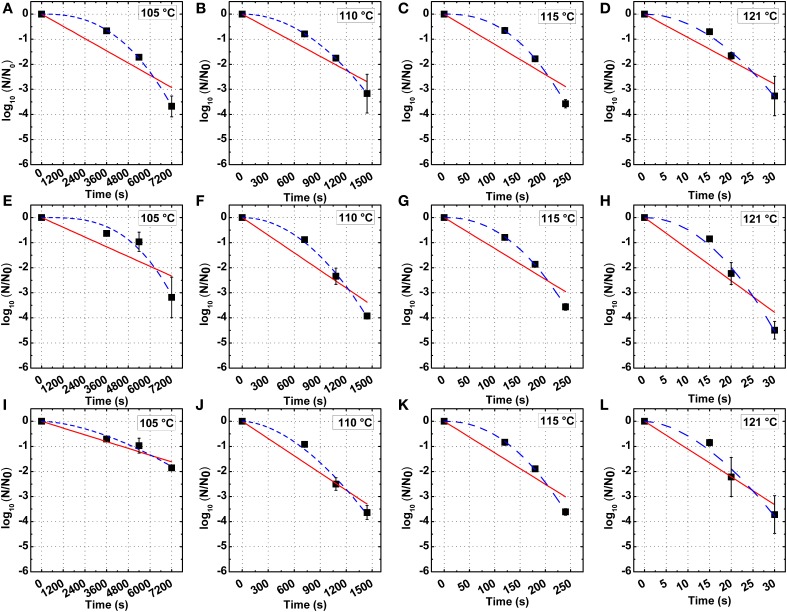
First-order (red continuous line) and Weibull (blue dashed line) model of the inactivation kinetics of B. amyloliquefaciens spores in PBS (A–D), low fat milk (E–H), and whole milk (I–L) at 105, 110, 115, and 121°C.